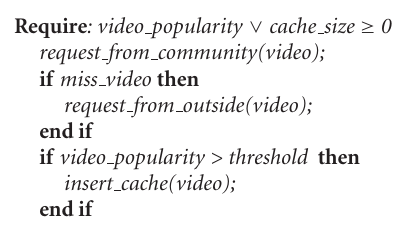
Algorithm 1: The popularity-based object management policy.